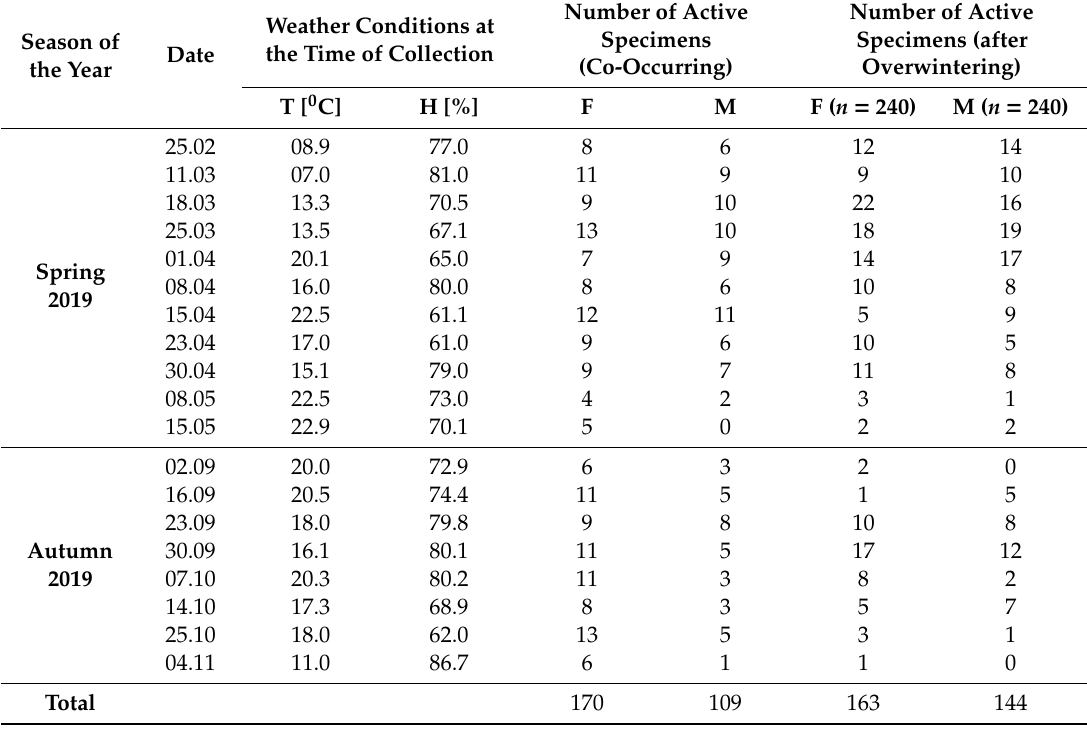
Table 1. Seasonal activity of Dermacentor reticulatus individuals assessed after overwintering and a local population of this species co-occurring in the examined site.